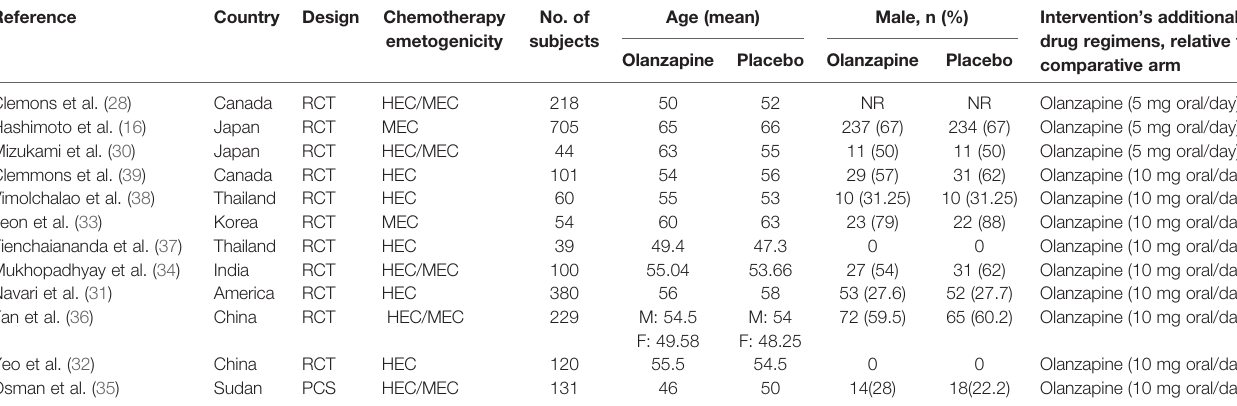
TABLE 1 | Study demographic.